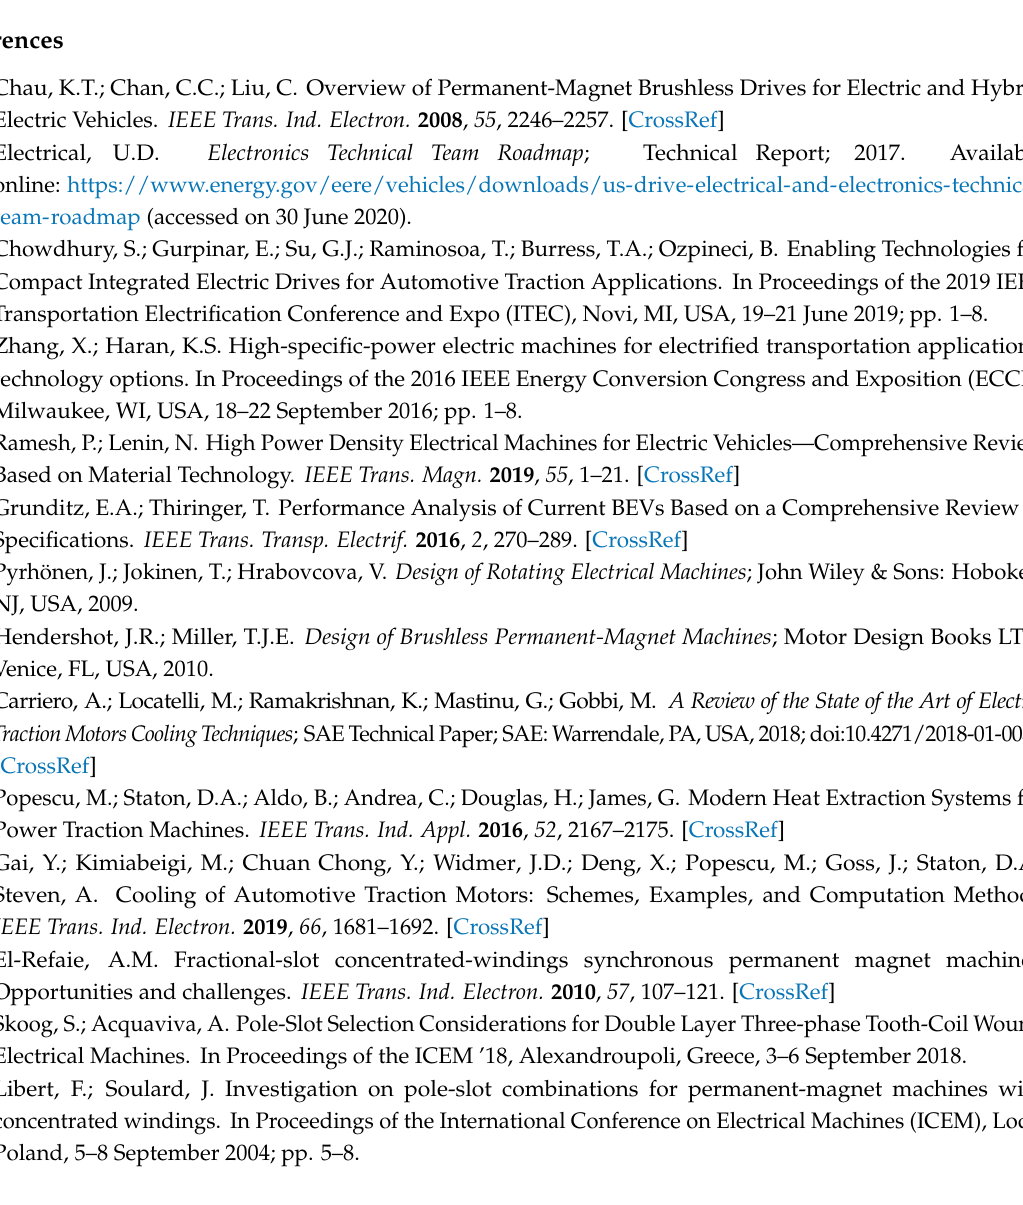
Figure A3. PM loss map from